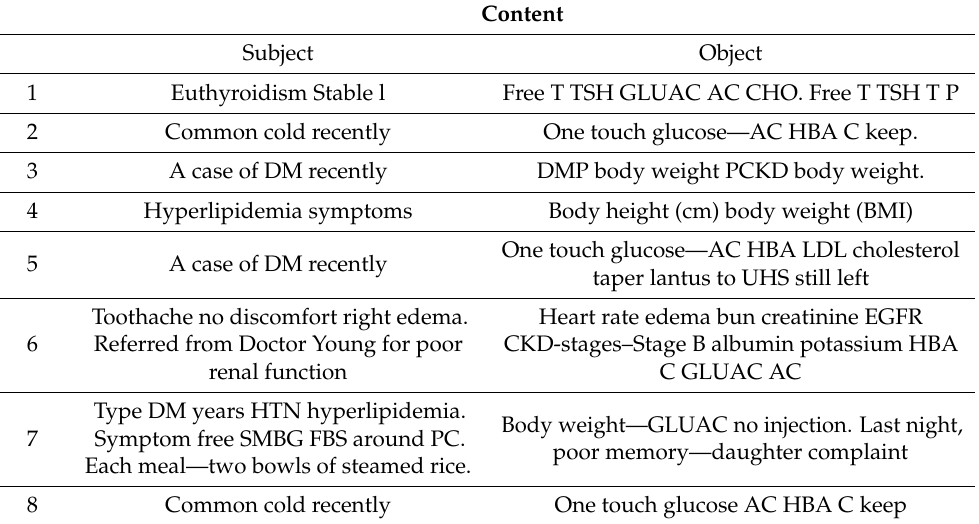
Table 1. Results of the data